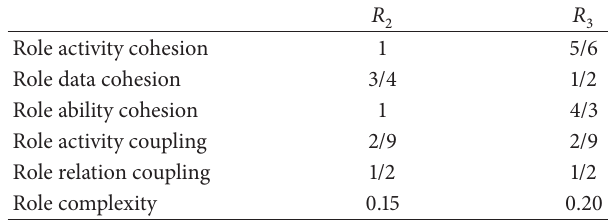
Table 4: Cohesion and coupling